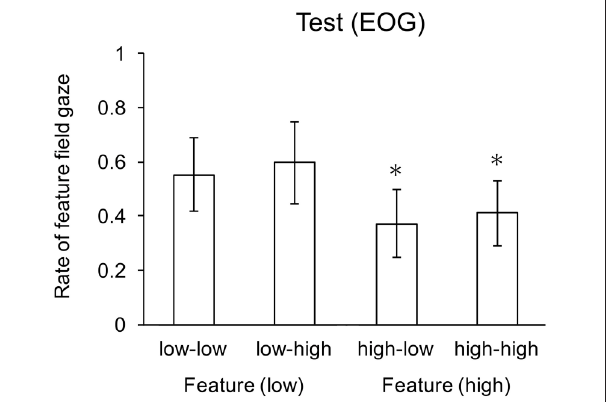
FIGURE 5 | Mean gaze rates to the feature search field. Whiskers indicate one standard deviation, and * indicates means significantly lower than chance.